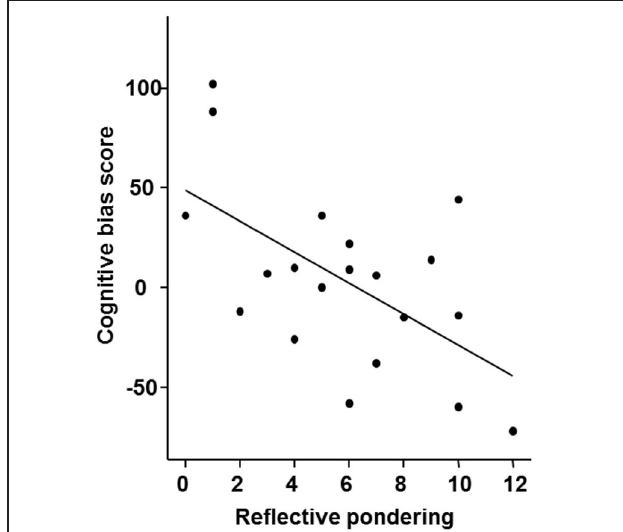
FIGURE 3 | Correlation of the cognitive bias score with the reflective pondering subscale of the Response Style Questionnaire ( p < 0 . 05; ρ = − 0 . 501).